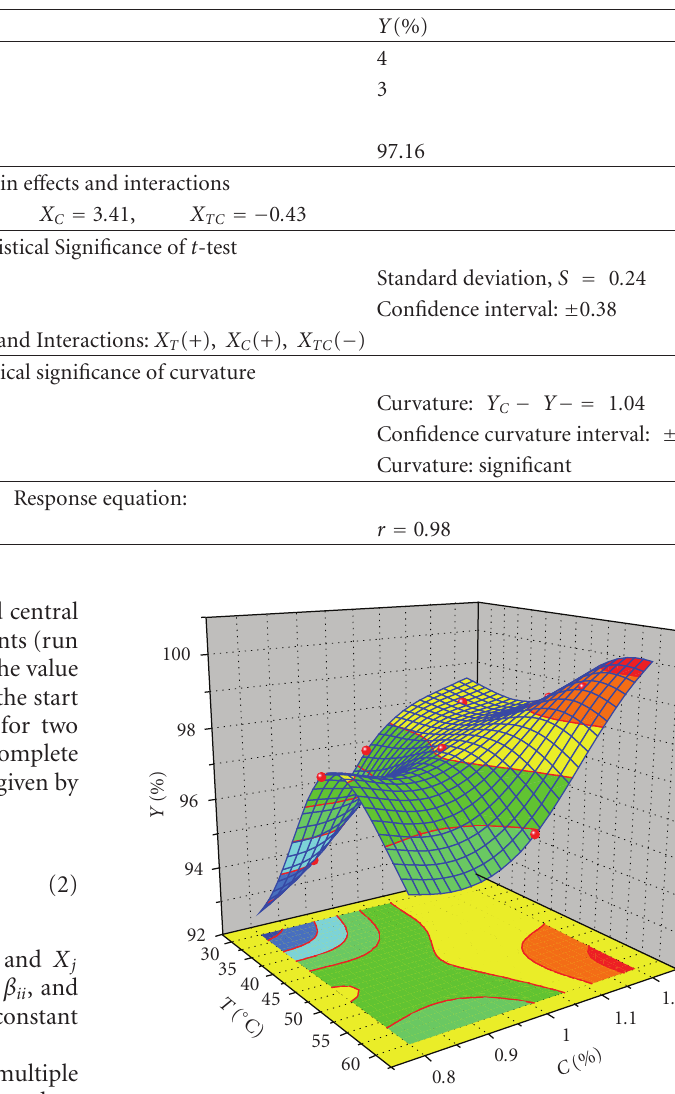
Figure 1: Experimental yield versus temperature and catalyst